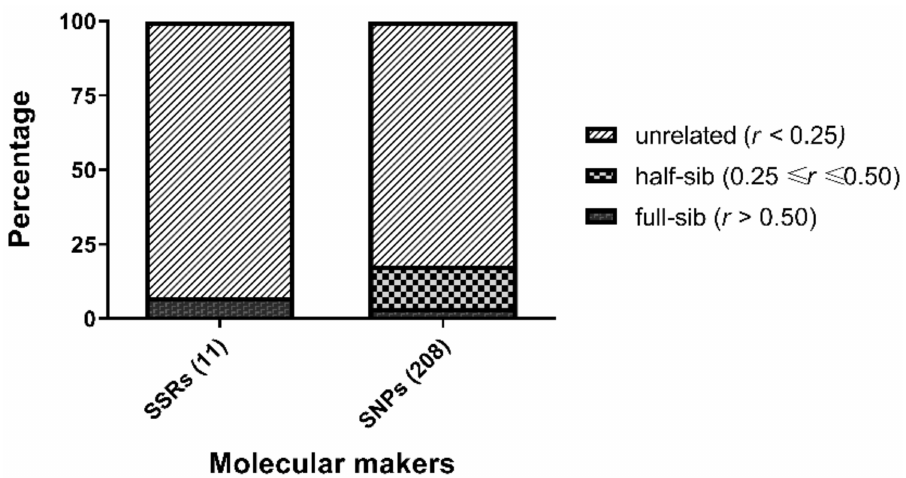
Figure 4. The distribution of relatedness value ( r ) of candidate parents calculated by wang estimator based on 208 SNPs or 11